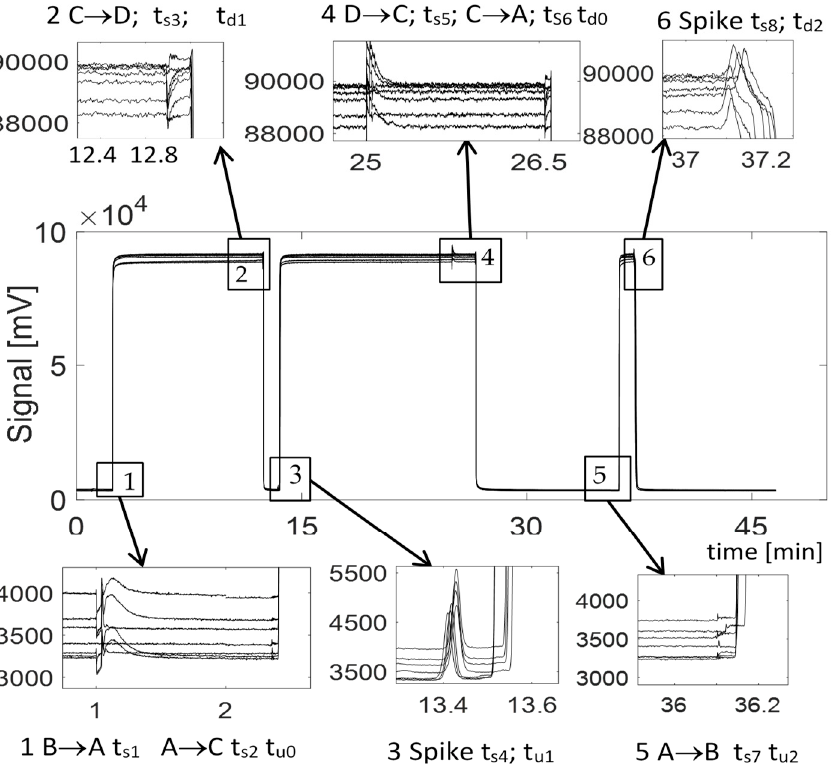
Figure 3. FID signal during measurement, spike times of events from Table 2 are reported at the boxes which zoom on the signal. Experimental raw data for the sample Sulfinert A at 100 SmL/min, 6 repeated experiments.